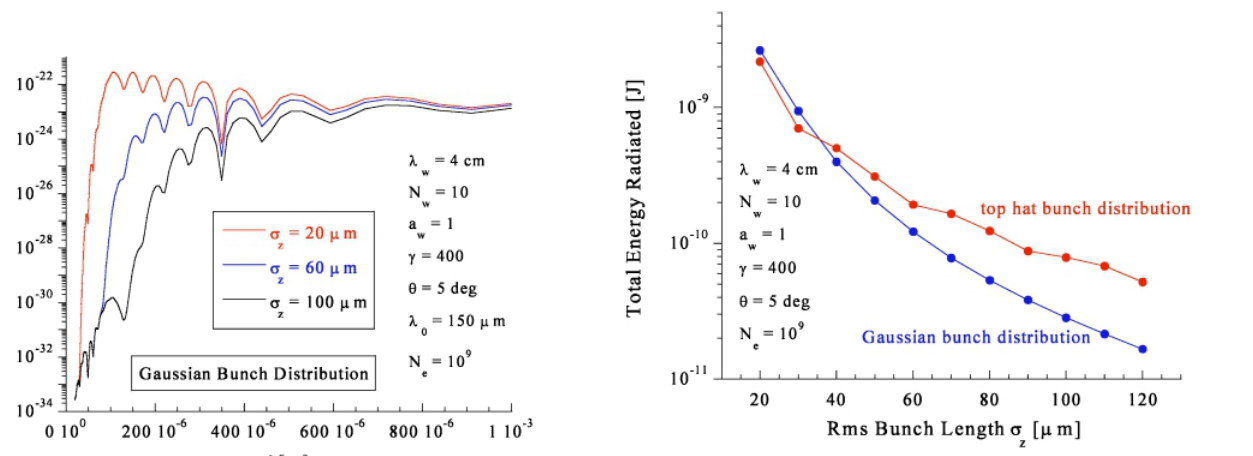
FIG. 10. (Color) Total integrated energy for various rms bunch lengths. The integration is performed from 20 m m to 1 mm, which is the anticipated response of the